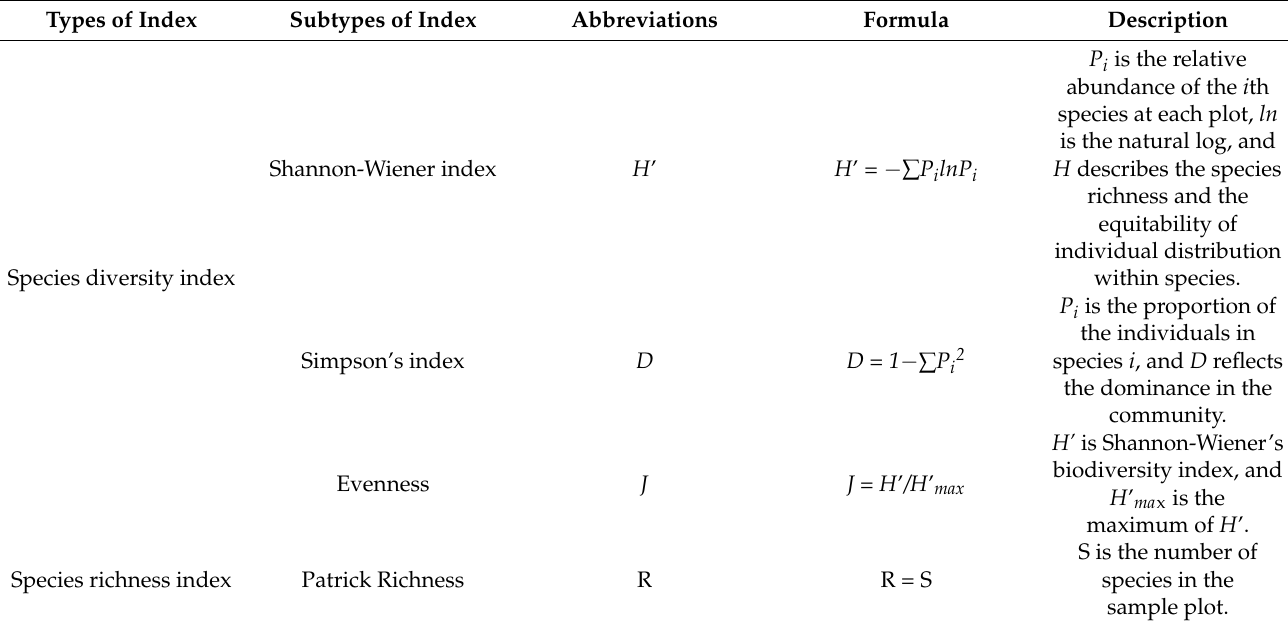
Table 3. The plant diversity indices selected in the study